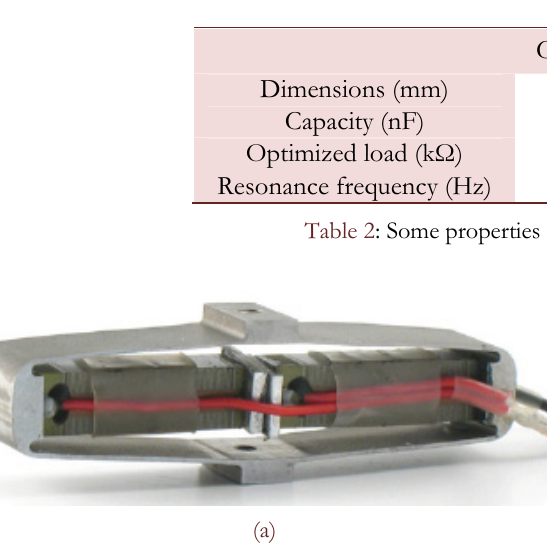
Figure 7: (a) Piezoelectric generator working in tension-compression VEH-APA 400M-MD (Cedrat Technologies); (b) laboratory prototype of flexural generator made with DuraAct P-876.A12 transducer.